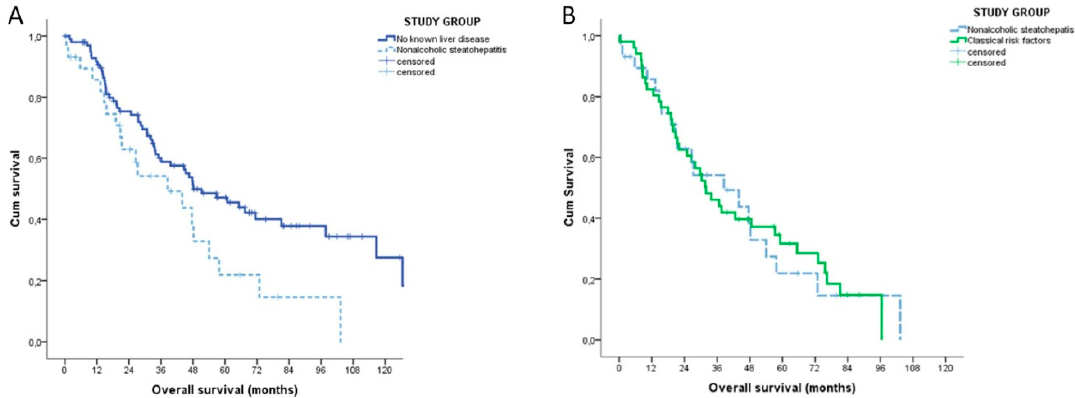
Figure 2. Kaplan-Meyer overall survival analysis of NASH patients ( n = 29). ( A ) Patients without any known causes of liver disease ( n = 100). ( B ) Patients with classical risk factors for intrahepatic cholangiocarcinoma ( n = 51).